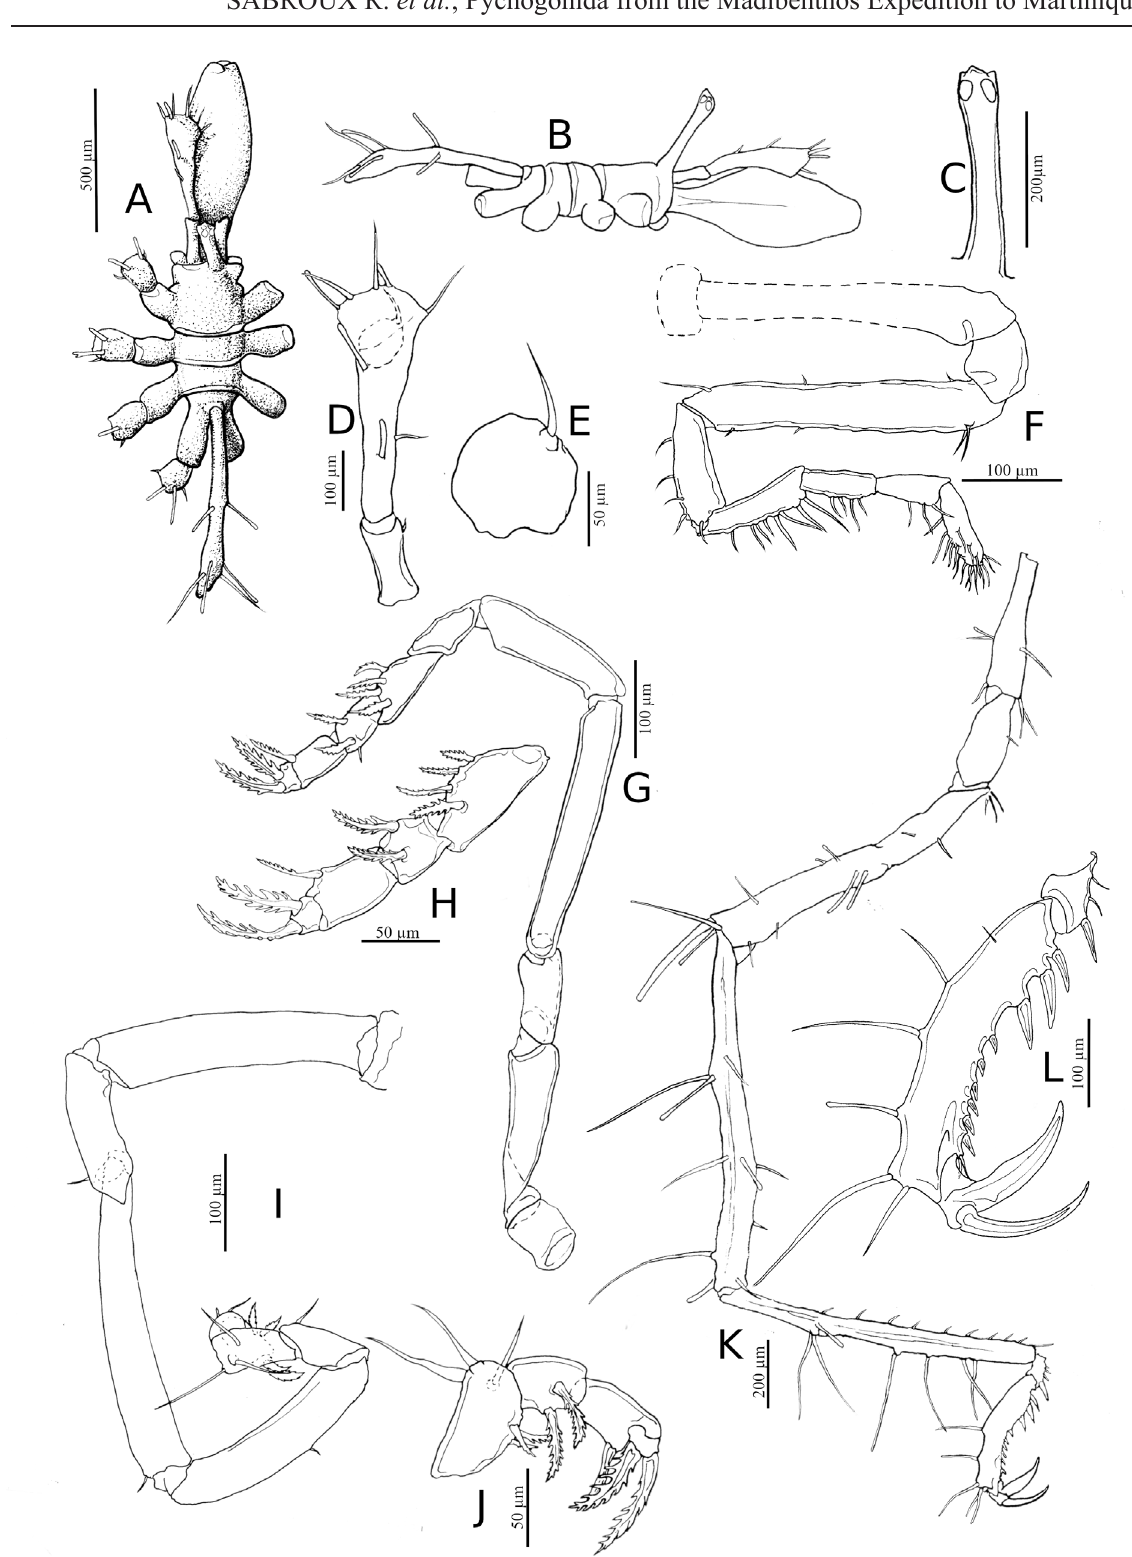
Fig. 2. Ammothella dirbergi sp. nov. A–F, I–L . Holotype, ♂, MNHN-IU-2016-83. G–H . Paratype, ♀, MNHN-IU-2016-1091. A . Body, dorsal view. B . Body, lateral view (same scale as A). C . Ocular tubercle, frontal view. D . Chelifore. E . Chela bud. F . Palp. G . Oviger. H . Oviger strigilis. I . Oviger. J . Oviger strigilis. K . Third leg. L . Tarsus and propodus of third